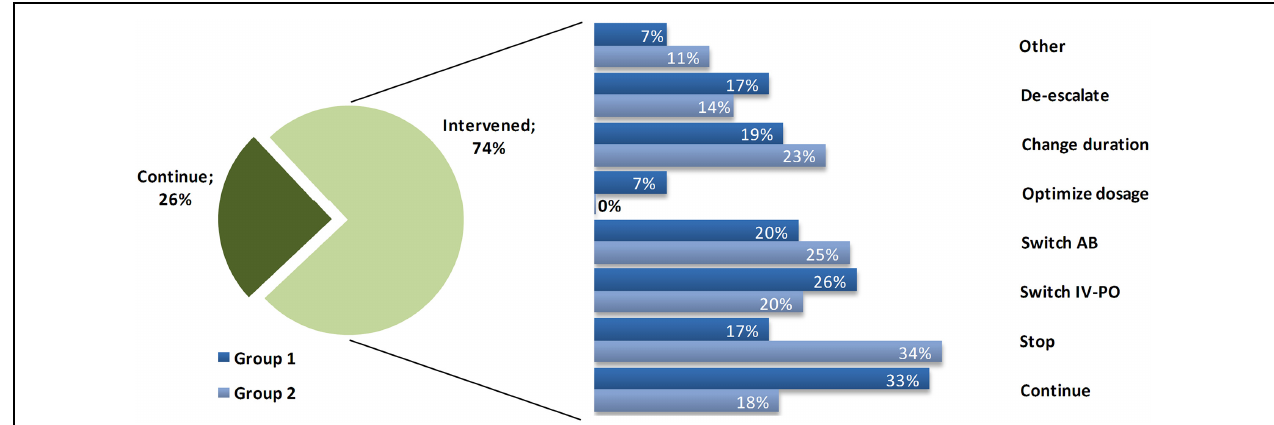
FIGURE 1 | Interventions performed. Distribution of the interventions performed for alert patients, subdivided into the two Groups. Percentages of interventions refer to the total number done within the 75% of intervened patients, where one patient can receive multiple interventions.